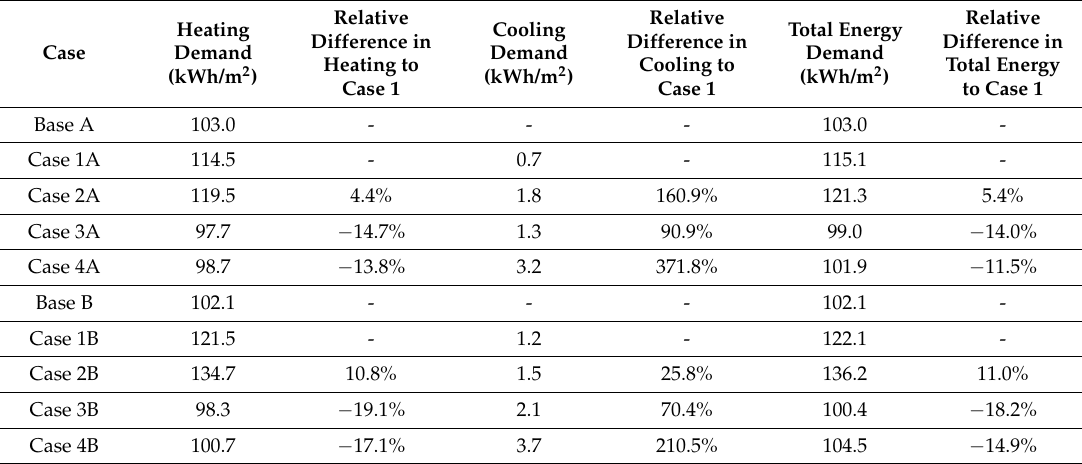
Table 6. Annual energy demand for heating and